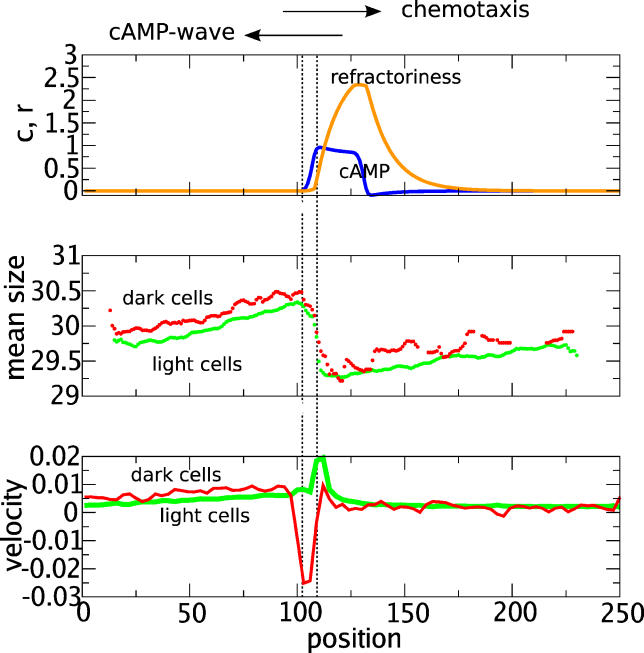
Volume Gradient and Cell Speed of a Freely Moving Cell Mass Chemotactically Responding to a Periodic cAMP SignalThe cAMP wave travels from the right to the left (as shown in the top panel, where c is cAMP, blue line; and r refractoriness, orange line). Cells only move chemotactically between the dashed vertical lines, when cAMP > 0.05 and refractoriness < 0.2. Consequently, chemotaxis is always directed to the right. In the middle panel, red and green dots indicate the average size of, respectively, dark and light cells. The bottom panel shows the average speed of the dark and light cells (given by the red and green lines, respectively). Parameters are Jl,l = 5, Jd,l = 3, Jd,d = 3 (γ = −1), λ = 5, μ = 200, V = 30, T = 6, and Hb = 0.8; cAMP dynamics are as described in [20], except that here the medium is also part of the excitable tissue, and that, throughout the tissue, excitability is 0.1. Average sizes were calculated as in Figure 2; average speeds were calculated by averaging the displacements of all cells within three-lattice-sites-wide strips over 100 intervals of 50 MCS, using a moving coordinate system linked to the cAMP wave.